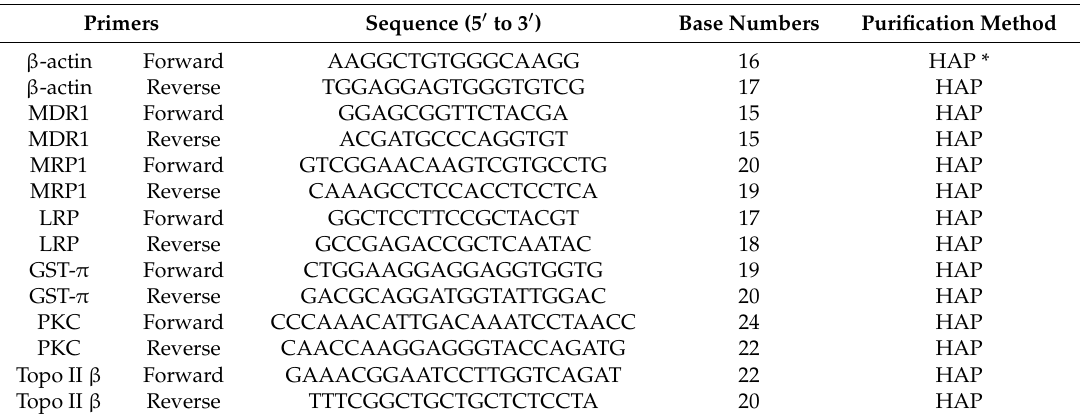
Table 3. List of primers